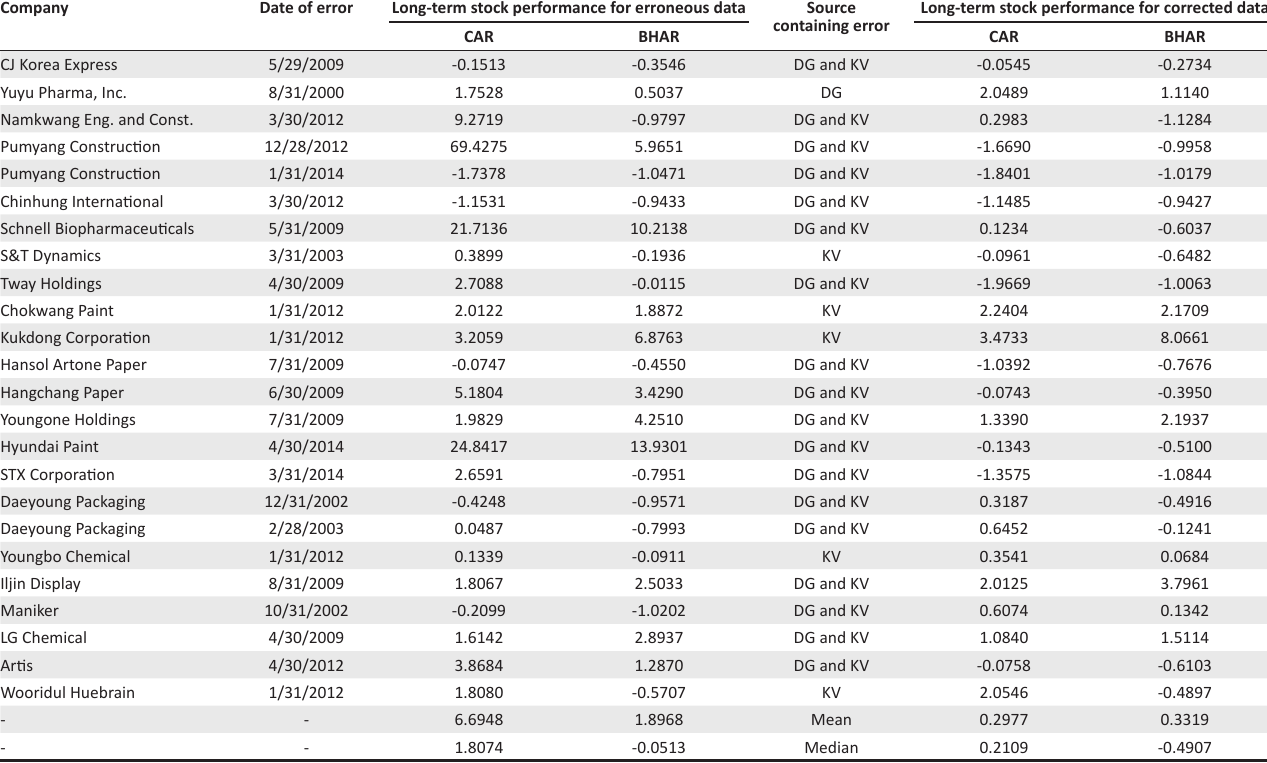
TABLE 5: The effect of large errors on long-term abnormal stock returns.